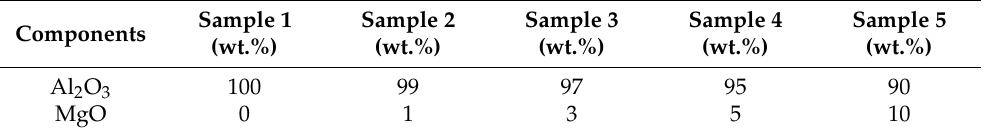
Table 1. Composition of ceramic